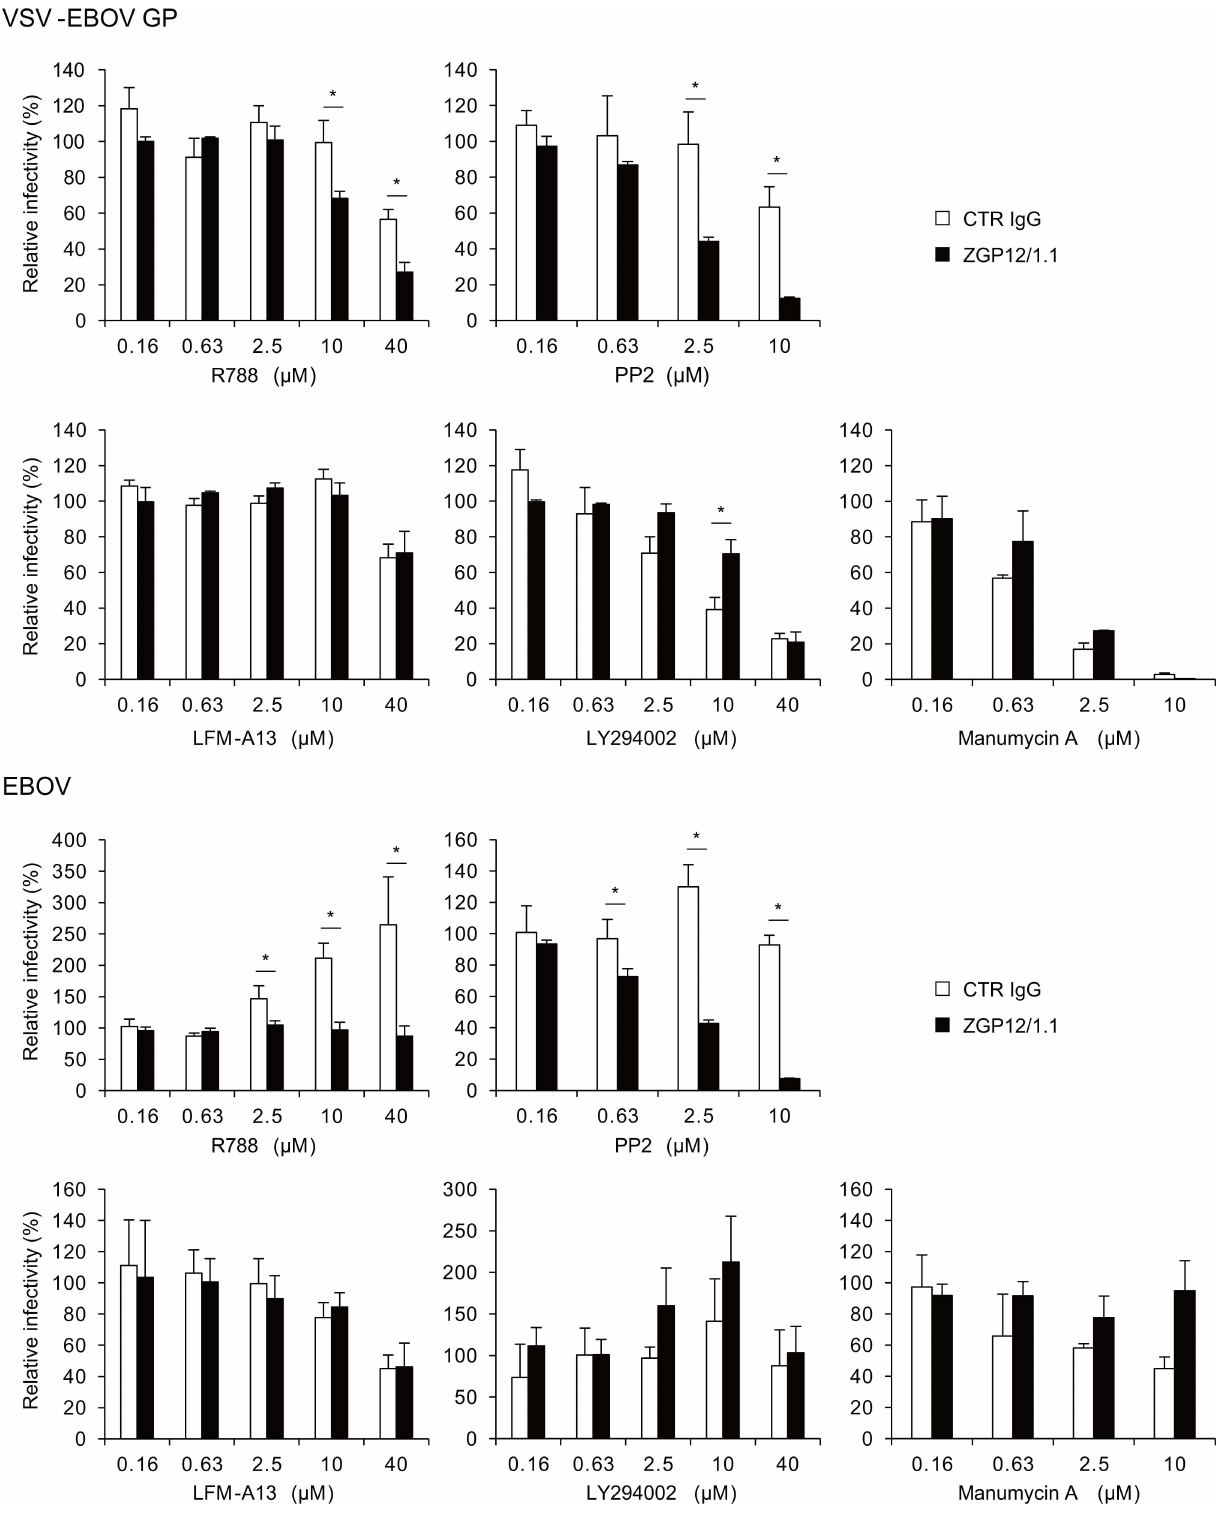
Fig 3. Identification of Fc γ RIIa-mediated signaling pathway for EBOV ADE. K562 cells were treated with the indicatedconcentrations of R788, PP2, LFM-A13, LY294002,or Manumycin A for 1 h at 37˚C and inoculated with VSV-EBOV GP or EBOV preincubatedwith CTR IgG, or ZGP12/1.1. The relative percentage of infectivity was calculatedby setting the IU value of the viruses in DMSO or ethanol-treated cells to